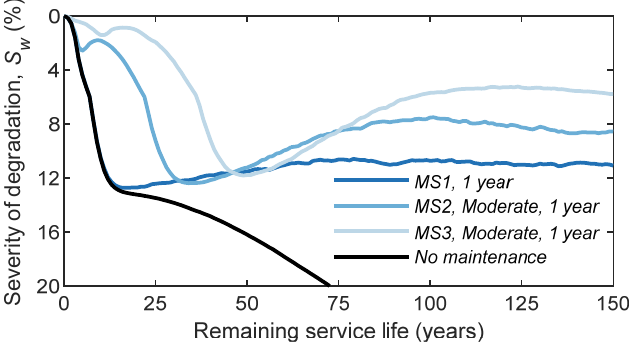
Figure 3. Degradation profiles of the three maintenance strategies and the situation without maintenance.